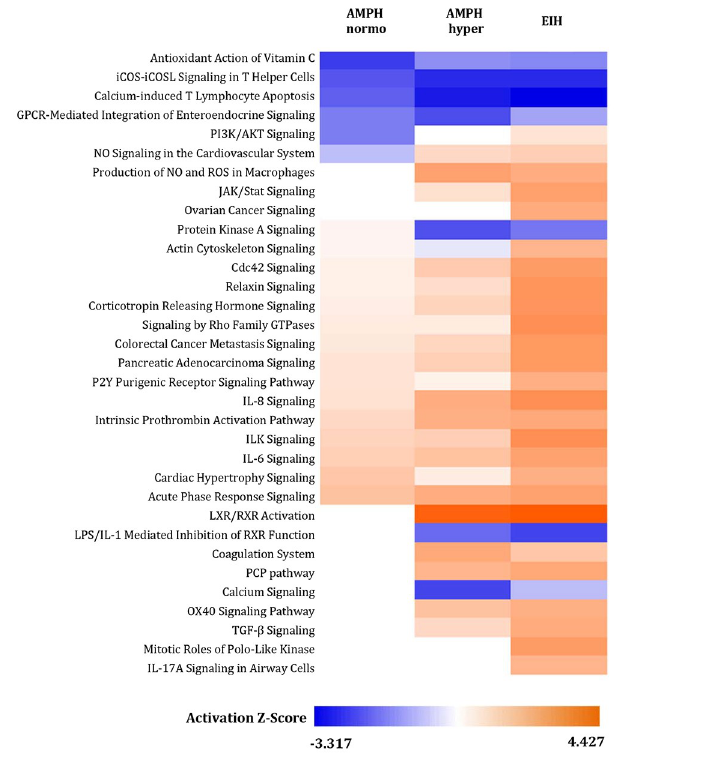
Fig 2. Heatmap displaying significant canonical pathways identified in the treatment groups of whole blood. The treatment groups AMPH normo, AMPH hyper, and EIH groups relative to control, and of AMPH hyper relative to AMPH normo and EIH were analyzed using the Fisher’s exact test at p < 0.01. The color gradient reflects the predicted direction of change for each pathway, based on regulation z-score, where blue represents inhibited and orange represents